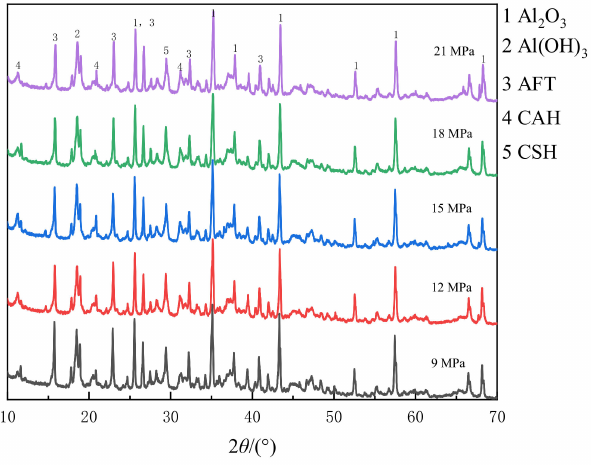
Figure 6. XRD analysis results of aluminum dross non-fired bricks under different forming pressures.